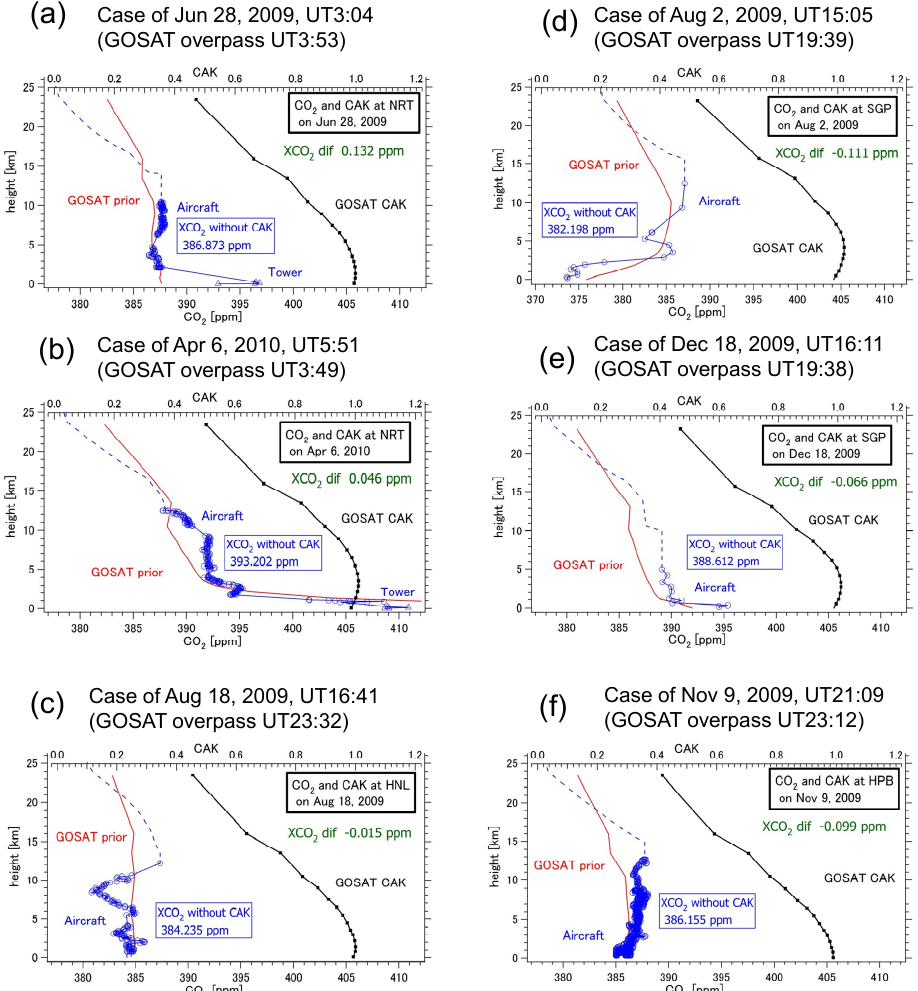
Fig. 3. Vertical profiles of CO 2 and GOSAT CAK over Narita on (a) 28 June 2009 and (b) 6 April 2010, over (c) Honolulu on 18 August 2009, over the Southern Great Plains on (d) 2 August 2009 and (e) 18 December 2009, and over (f) the South Pacific Ocean (site code: HPB) on 9 November 2009. The blue lines show the profiles of observation data, including aircraft measurements. The red lines show the GOSAT a priori profiles. The black lines are GOSAT CAKs. Aircraft-based XCO 2 without the application of GOSAT CAK and the differences between aircraft-based XCO 2 with and without the application of GOSAT CAK are indicated by blue and green letters, respectively.